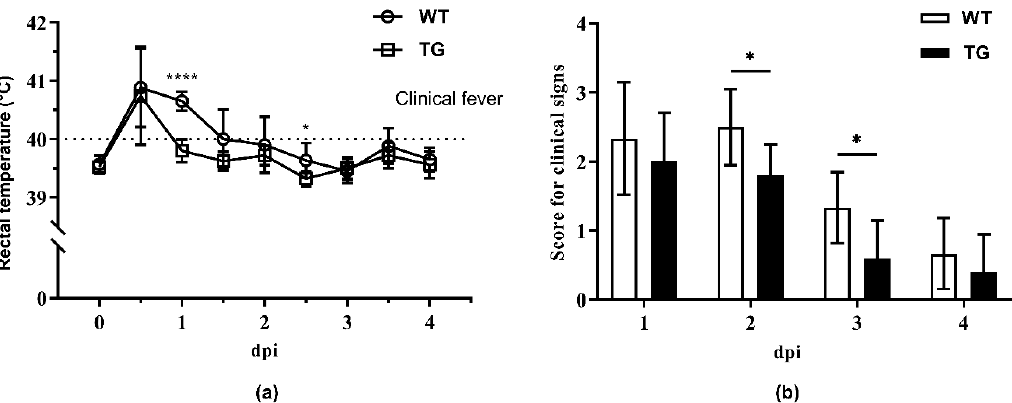
Figure 2. Clinical monitoring during cohabitation. Transgenic (TG, n = 5) and wild-type (WT, n = 6) pigs were cohoused with 11 other WT pigs intratracheally infected with G. parasuis . ( a ) Rectal temperature of pigs was recorded during the four-day cohabitation postinfection. ( b ) Scores for clinical signs in both WT and TG groups during the four-day cohabitation postinfection. Data are presented as mean ± SD. * p < 0.05, **** p < 0.0001, unpaired one-tailed Student ′ s t -test.